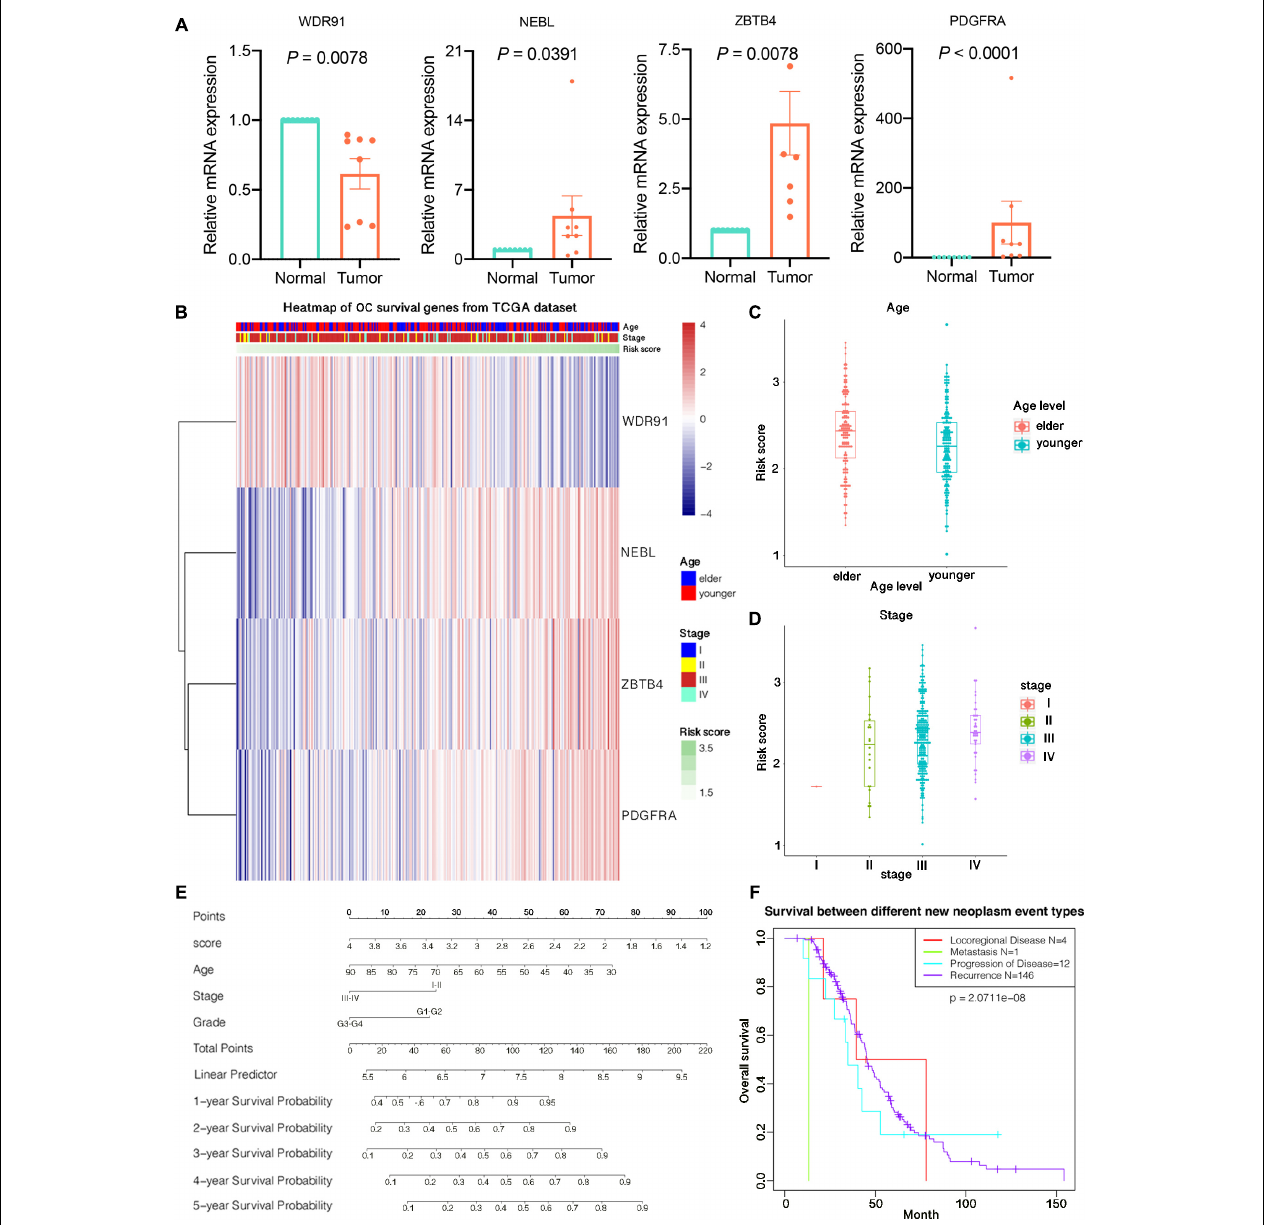
FIGURE 3 | Relationship between prognostic risk score and clinicopathological characteristics of ovarian cancer. (A) Expression of 4 prognostic predictors in ovarian cancer tissues and normal tissues. (B) The expression profile of clinical characteristics of high and low risk groups. The horizontal axis is four candidate prognostic genes. Red and blue indicate the expression value of each gene corresponding to each sample, and the vertical axis is the sample. Each top is shown from top to bottom. Age, stage, and risk score information for each sample, where all samples are ranked according to risk score from low to high. (C) Differences in risk scores between patients of different ages. (D) Differences in risk scores between patients of different stages. (E) Predicting patients 1–5-years survival with risk scores using nomograms. (F) Survival curves between different new tumor event samples in TCGA